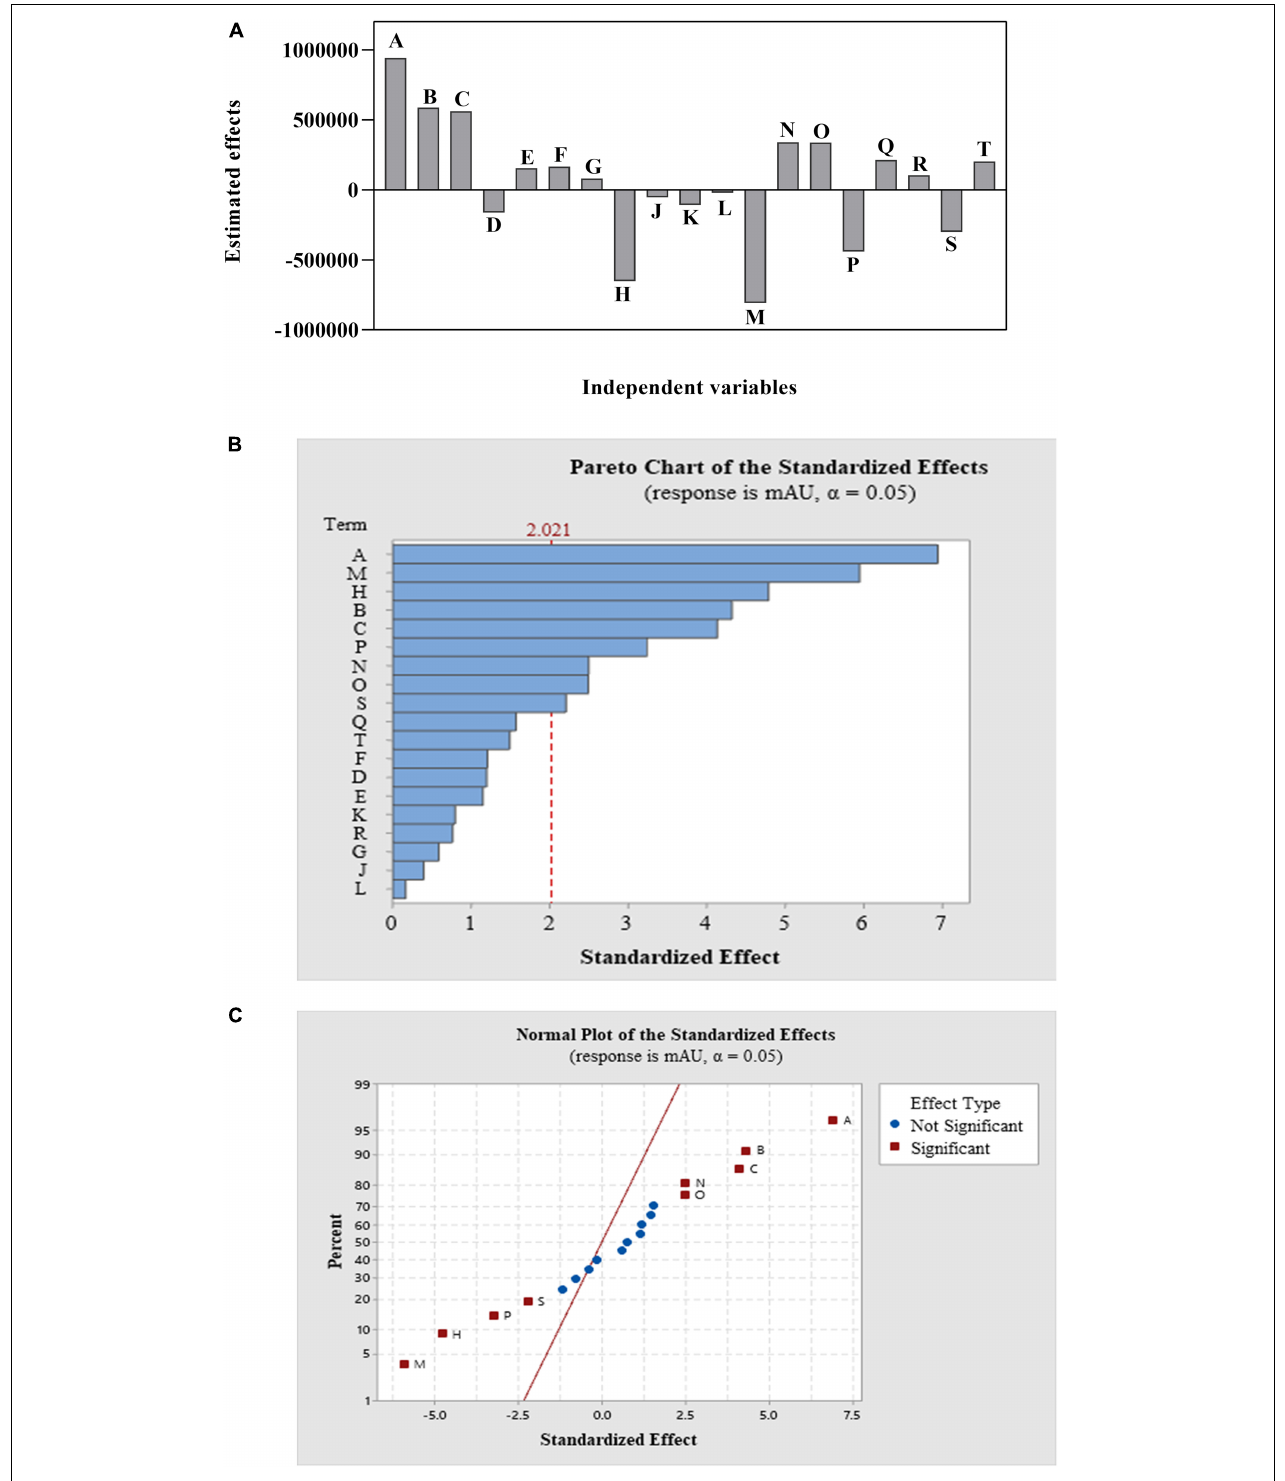
FIGURE 2 | The main effects of the variables (A) and Pareto chart of the standardized effects of 14 variables design at a 95% confidence level (B) and the normal plot of the standardized effects of 14 variables design at a 95% confidence level (C) of a Plackett–Burman design for cyclopiazonic acid production by Penicillium commune KACC